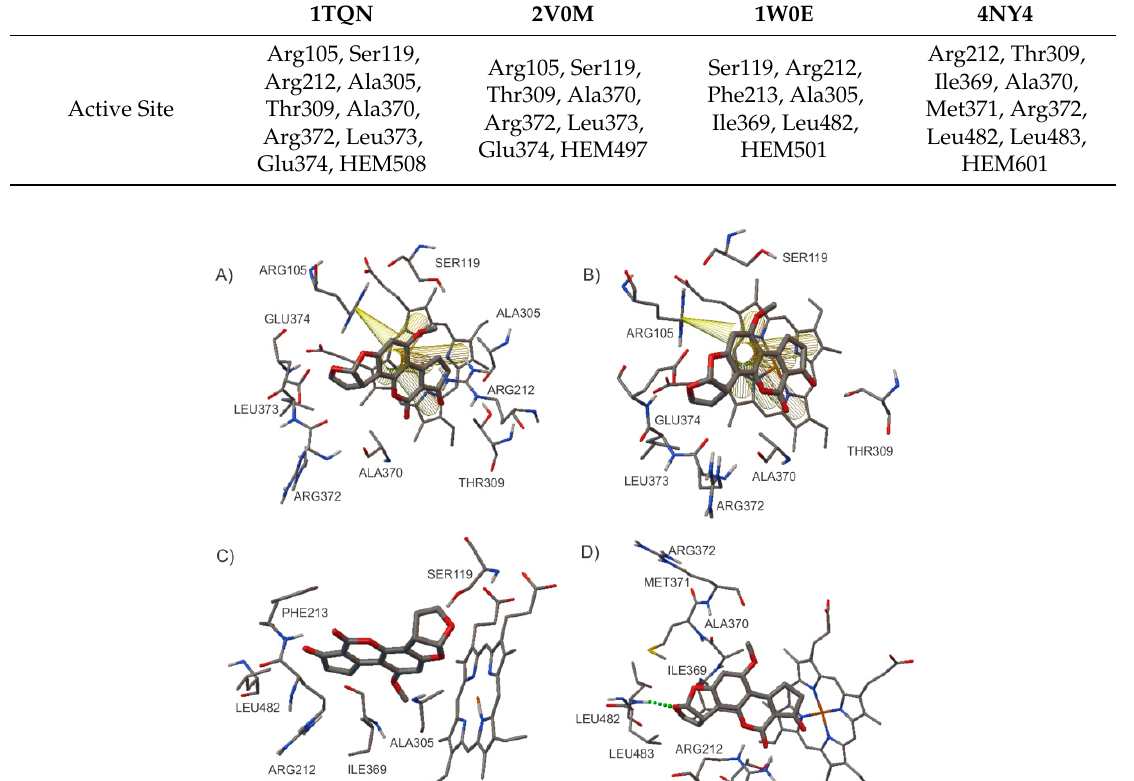
Table 5. Chemical reactivity parameters of amino acids present in the active sites of CYP3A4 (using different PDB IDs) provided by the interaction with aflatoxin AFB1.